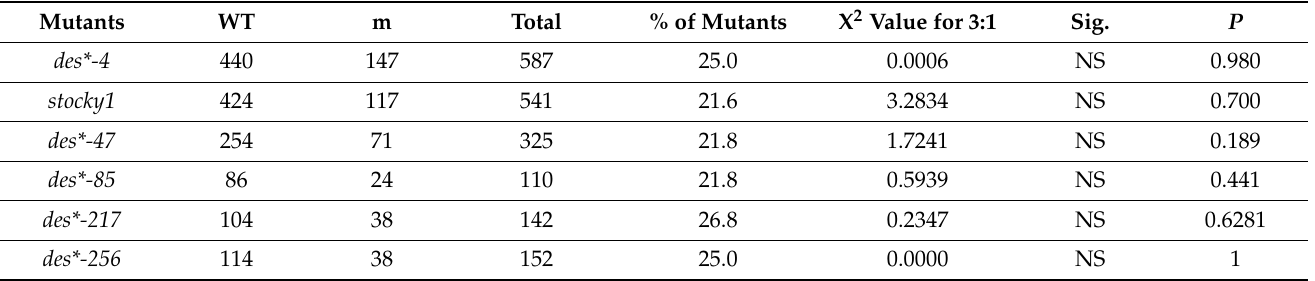
Table 2. Results of the complementation test of the des* mutants crossed inter se. (+) and (–) indicate complementation and non-complementation, respectively.